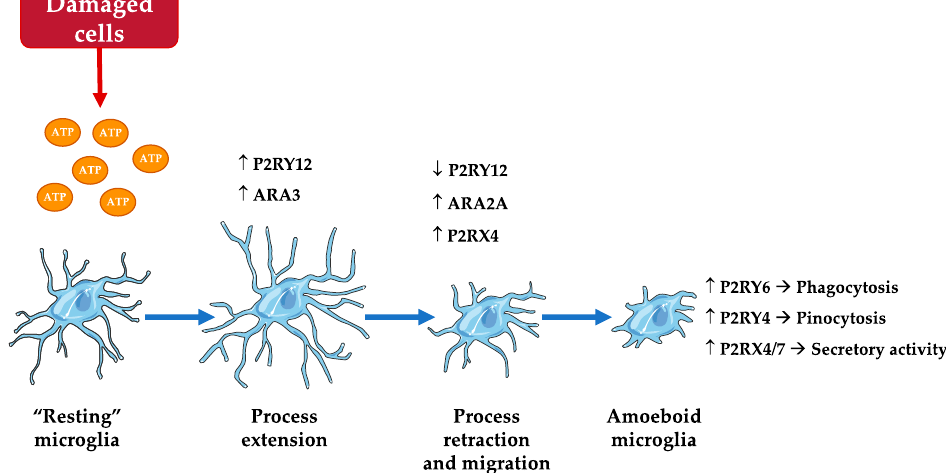
Figure 2. Purinergic receptors and microglial activation states (modified from [37]). In response to ATP release from damaged cells, P2RY12 stimulation triggers the extension of microglial processes towards the site of injury, in cooperation with the adenosine receptor (AR) A3. Both these receptors are upregulated during this step. Then, P2RY12 downregulation and ARA2A upregulation induce the retractation of these processes. Microglial migratory activity also depends on the interaction between P2RY12 and P2RX4. After total retraction of processes, microglia adopt an amoeboid morphology, and exert phagocytosis, pinocytosis or secretory activity depending on the receptor involved. ↑ : upregulation or increased activation; ↓ : downregulation or reduced activation.